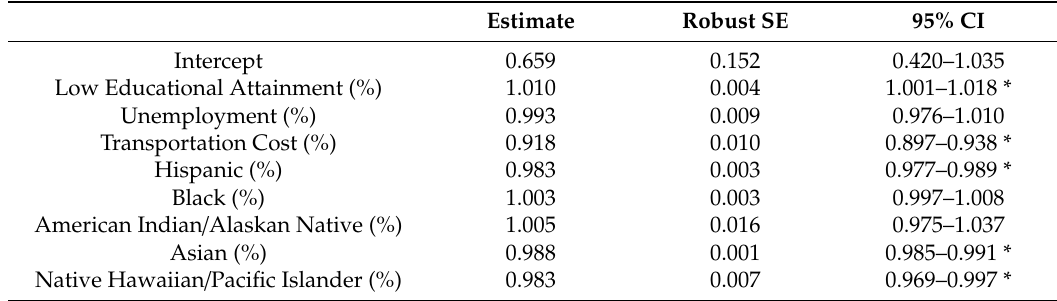
Table 5. Results of multivariate model of COVID-19 testing based on SES and race / ethnicity variables. Estimates and 95% CIs are the exponentiated coe ffi cients of the Poisson model, with statistically significant associations indicated with an